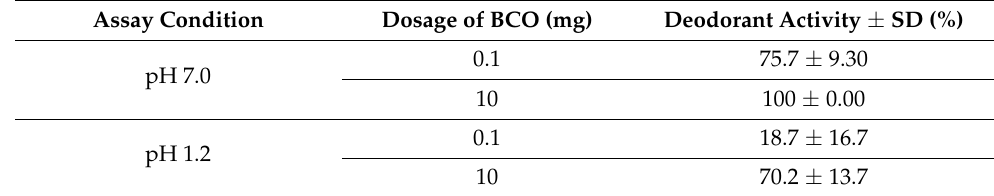
Table 1. Deodorant activity of black cumin seed oil (BCO) against 0.5 µ g of allyl mercaptan (AM). Assay